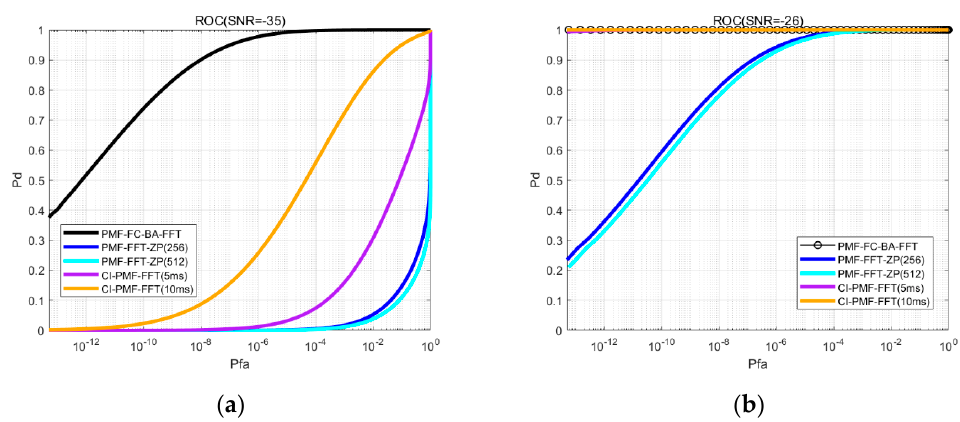
Figure 11. ( a ) ROC curves when SNR was − 35 dB; ( b ) ROC curves when SNR was − 26 dB.